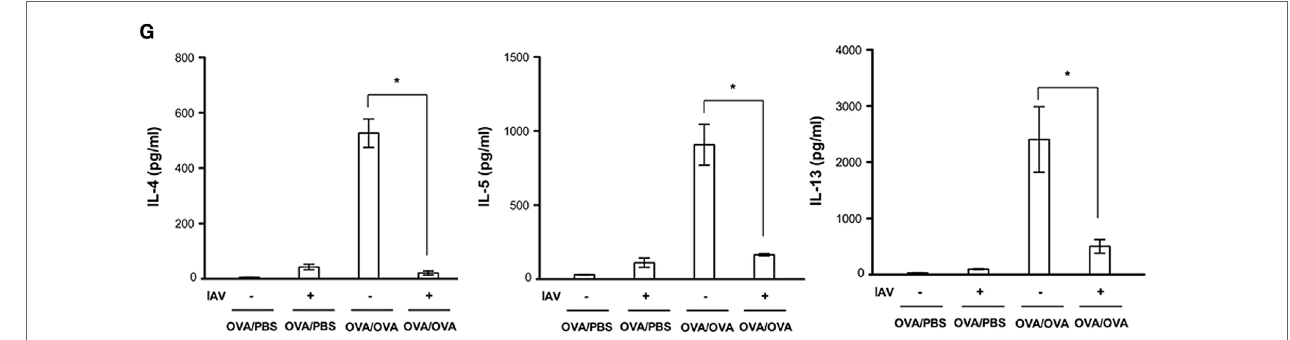
FigUre 2 | Kinetics of influenza A virus (IAV) infection in non-asthmatic and asthmatic mice. Non-asthmatic ( N = 5) and asthmatic mice ( N = 5) were infected with 213 pfu IAV WS/33 (H1N1), and body weight (a) and survival rate [ (B) , N = 20] were assessed until 7 dpi. The IAV mRNA (c) and viral titer (D) in lung tissue and bronchoalveolar lavage (BAL) fluid, respectively, were determined at 7 dpi. Hematoxylin/eosin (H&E)-stained micrographs were also generated from lung sections obtained at 7 dpi (e) . Histological assessment for mucus secretion was performed on periodic acid Schiff (PAS)-stained lung sections of asthmatic mice (F) . A multiplex assay was performed to quantify the levels of secreted Th2 cytokines (i.e., IL-4, IL-5, and IL-13) in the BAL fluid of non-asthmatic and asthmatic mice (g) . Micrographs shown are representative of lung sections from five mice. Polymerase chain reaction, plaque assay, and multiplex assay results are presented as mean ± SD from five independent experiments (* p < 0.05 compared with the levels of non-asthmatic and asthmatic mice at 7